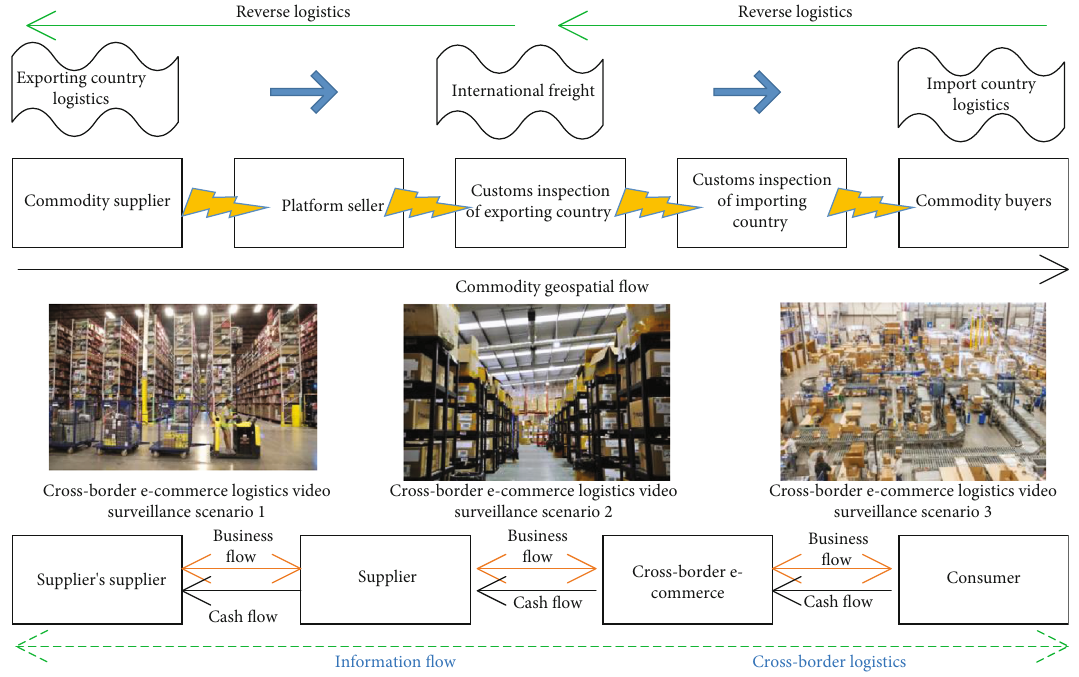
Figure 2: Structure design of cross-border e-commerce logistics video surveillance